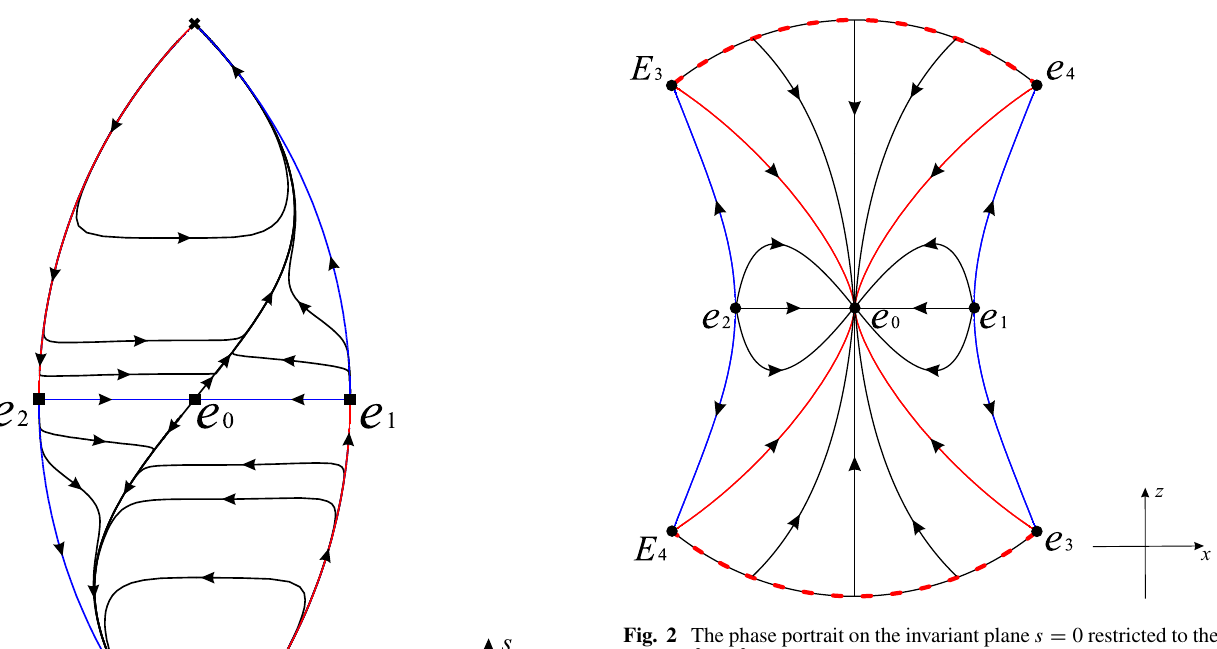
xs Fig. 2 The phase portrait on the invariant plane s = 0 restricted to the region x 2 − z 2 ≤ Arbitrary